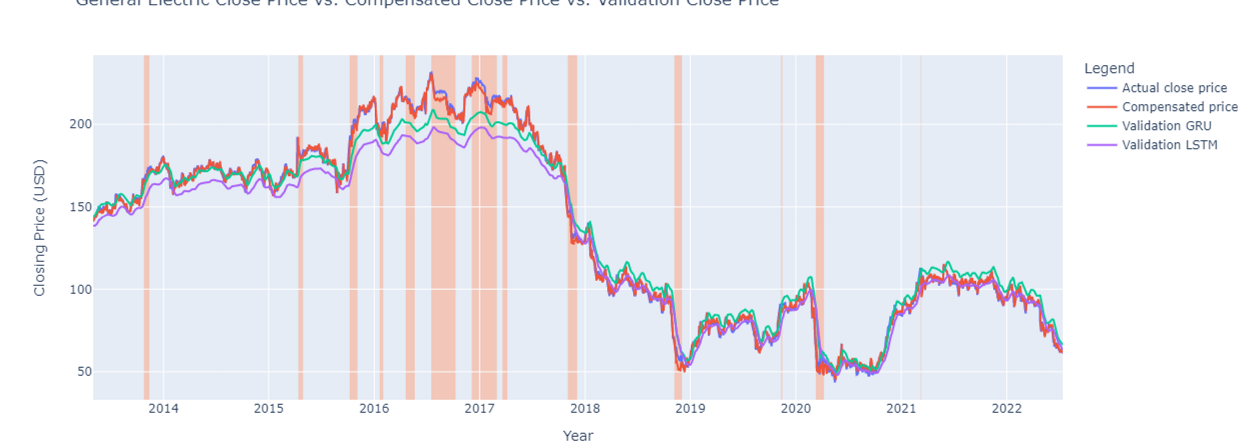
Figure 10. Output prediction of the proposed method compared to the validation models and ground truth stock